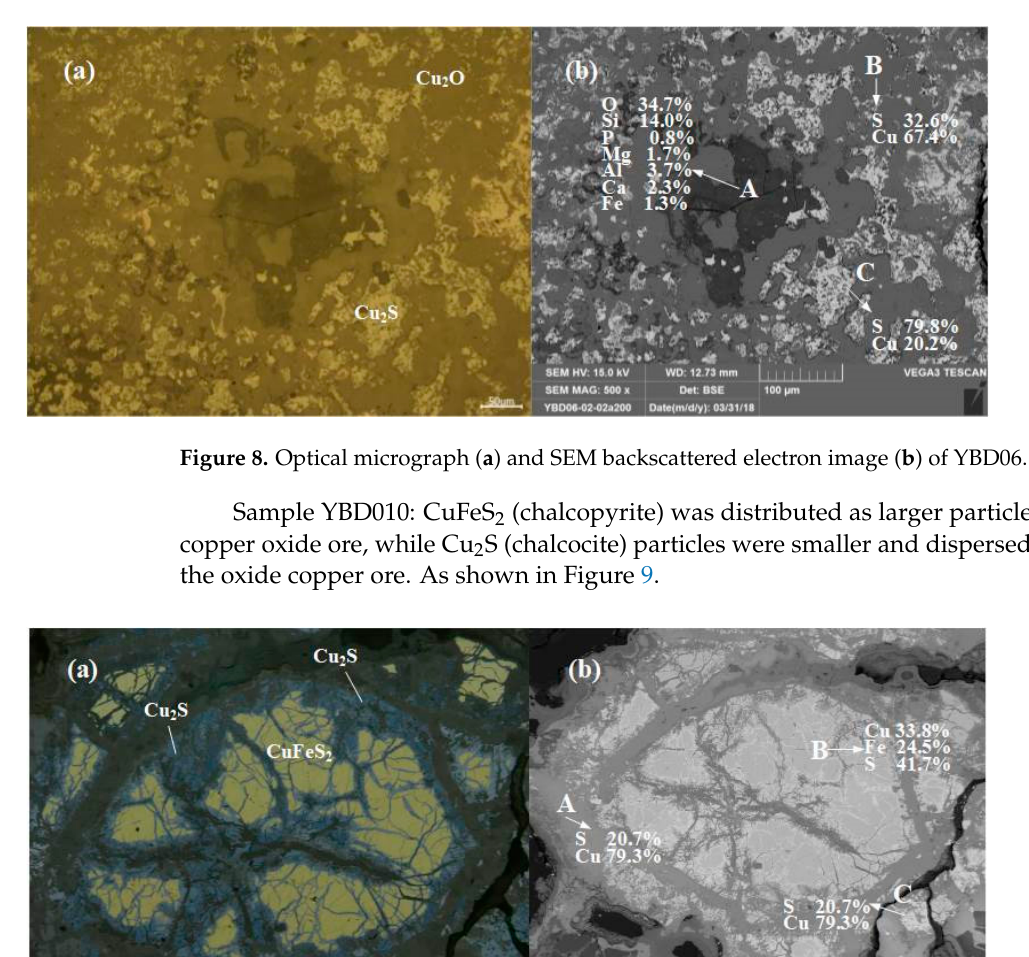
Figure 7. Optical micrograph ( a ) and SEM backsca tt ered electron image ( b ) of YBD03.